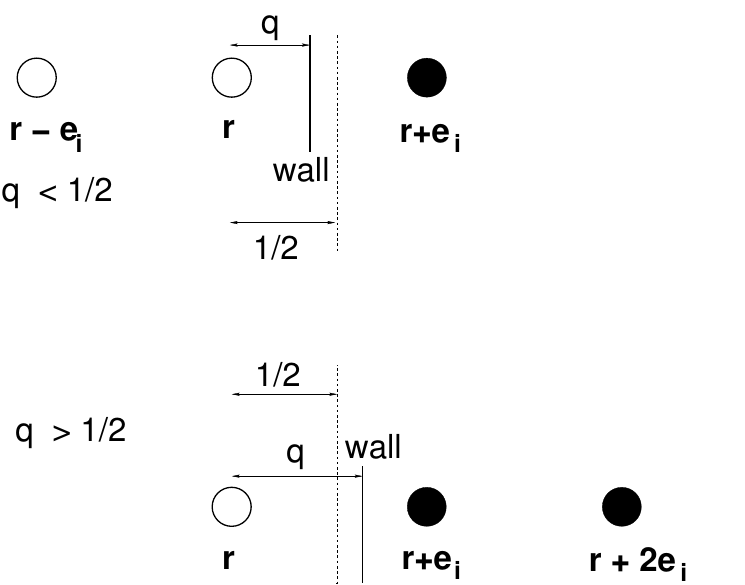
Figure 1. Diagram for calculating Dirichlet boundary conditions for concentration field when bound- ary nodes are partially filled. White circles denote fluid nodes and black circles are solid nodes. The node at r is the last node before the wall (vertical black line) and may be partially filled with